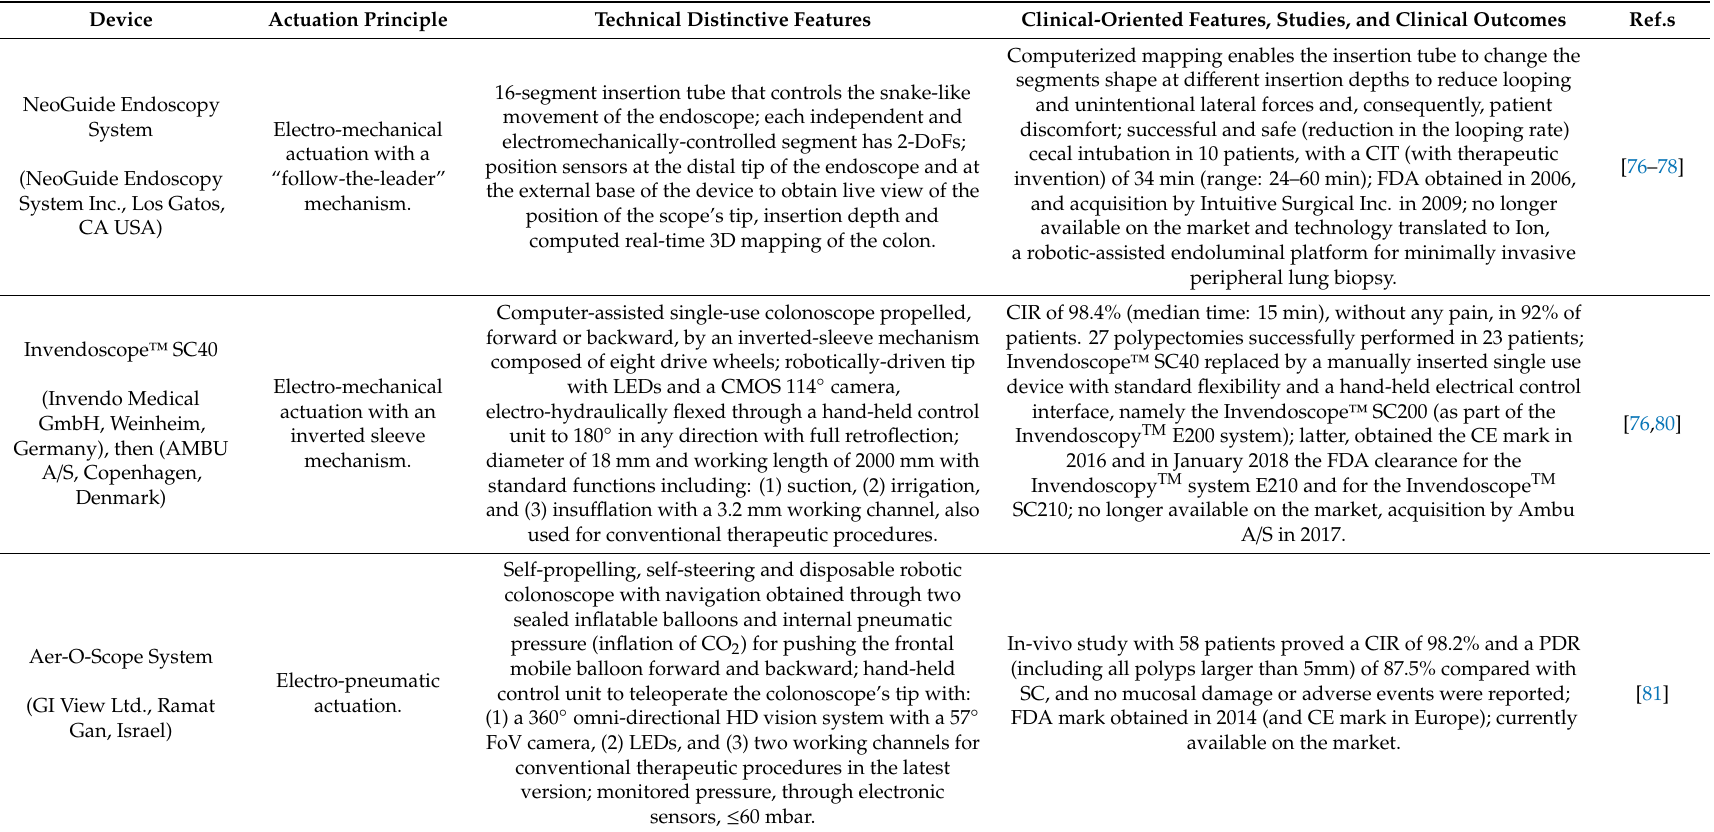
Table 2. Summary of the technical distinctive features and / or clinical outcomes (if available) of robotic flexible colonoscopes, that obtained approval and certification to be market-available (commercially-available or no longer on the market). NaviCam ® has not been detailed in this table because it is not applied yet in colonoscopic